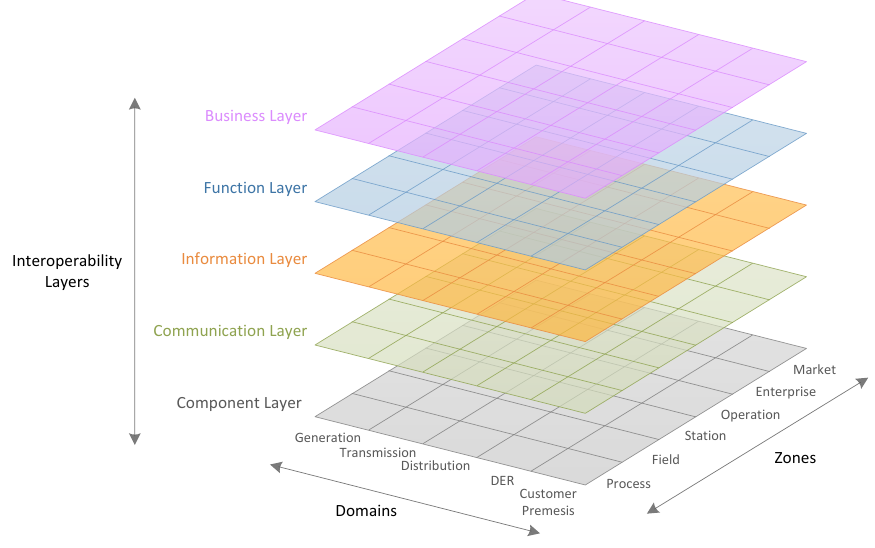
Figure 1. Overview of the Smart Grid Architecture Model (SGAM), based on